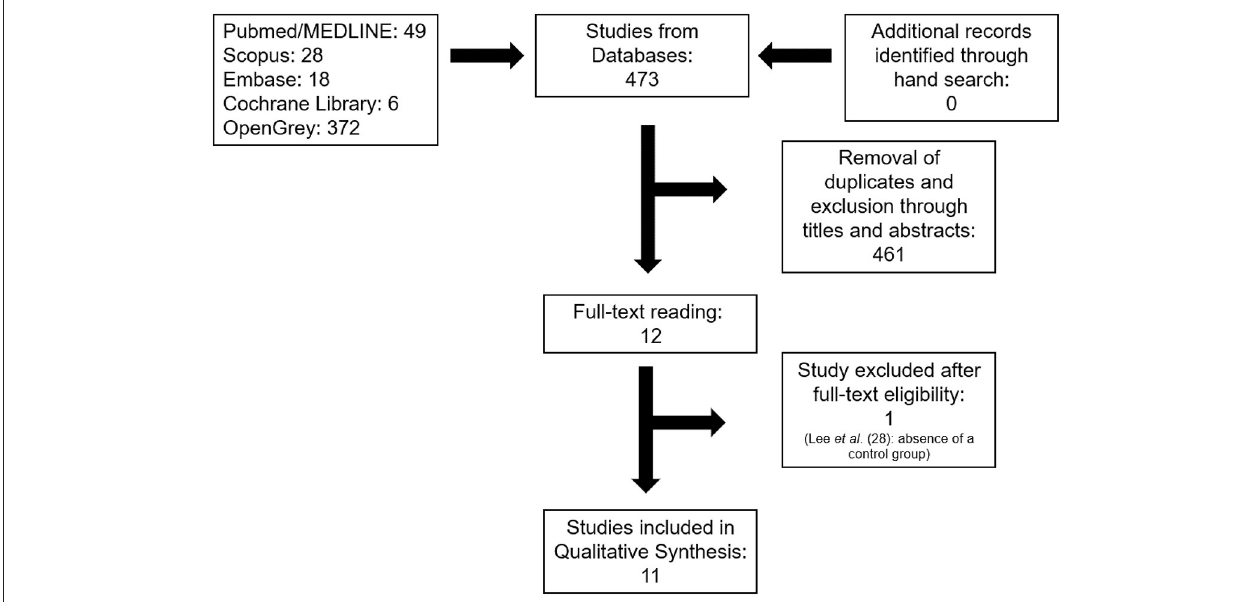
FIGURE 1 | Flow diagram of the search strategy of the systematic review following the Preferred Reporting Items for Systematic Reviews and Meta-analyses (PRISMA)